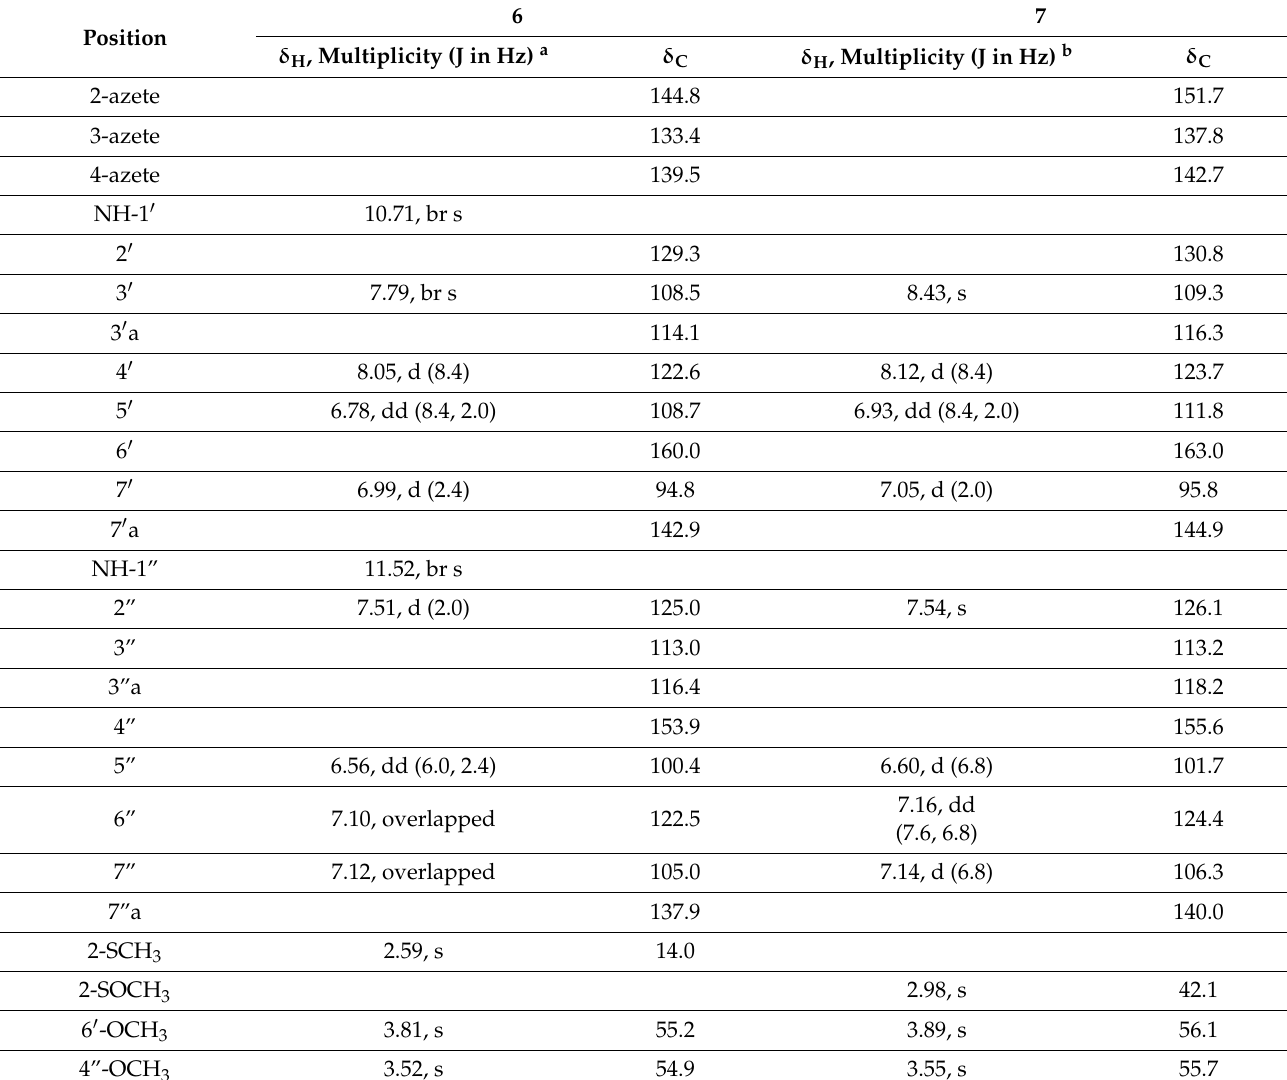
Table 3. 1 H- and 13 C-NMR data for compounds 6 –